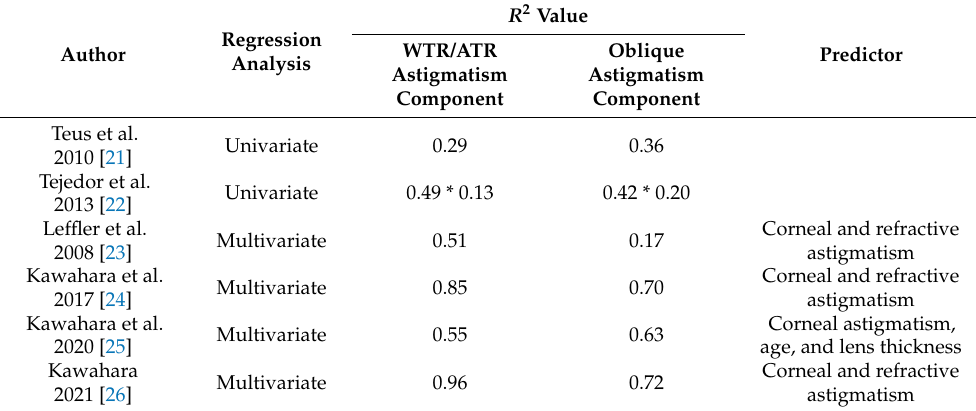
Table 1. Overview of studies focusing on the correlation between refractive and corneal astigmatism using vector analysis in eyes receiving non-toric intraocular lenses